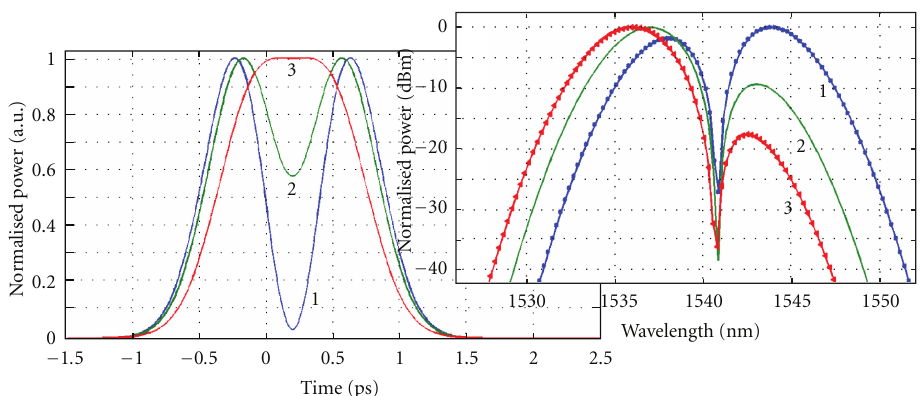
Figure 8: Traces in ascending order of pulse intensity profiles (left) and respective spectra (right) for detuning of the signal input wavelength away from the interference fringe of the cascaded LPG filter pair.